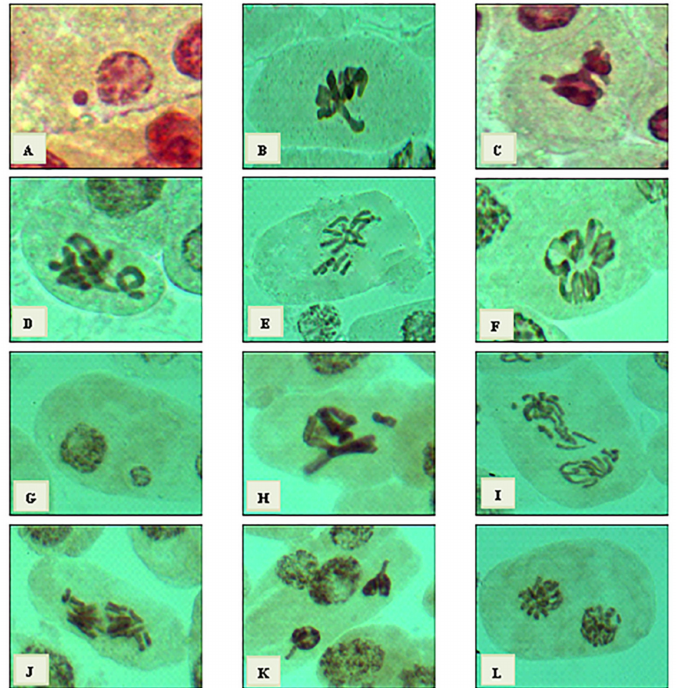
Figure 9. Types of mitotic abnormalities resulting from treatments of V. faba root tips with crude latex and Cy-AgNPS concentrations. From ( A – F ) crude latex, ( A ) micronucleus at interphase stage, ( B ) disturbed at metaphase, ( C ) stickiness at metaphase, ( D ) ring at metaphase, ( E ) oblique at metaphase, and ( F ) star at metaphase. From ( G – L ) Cy-AgNPs (25 mg/L), ( G ) micronucleus at interphase, ( H ) non-congression at metaphase, ( I ) laggard at anaphase, ( J ) disturbed at anaphase, ( K ) disturbed at telophase, and ( L ) diagonal at telophase. (X =